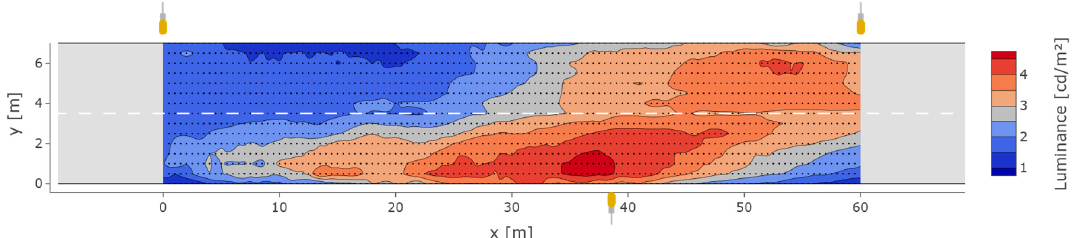
Figure 8. Location of the luminaires on the roadway and experimental luminance collected. Black dots show the distribution of the points at which measurements were taken.